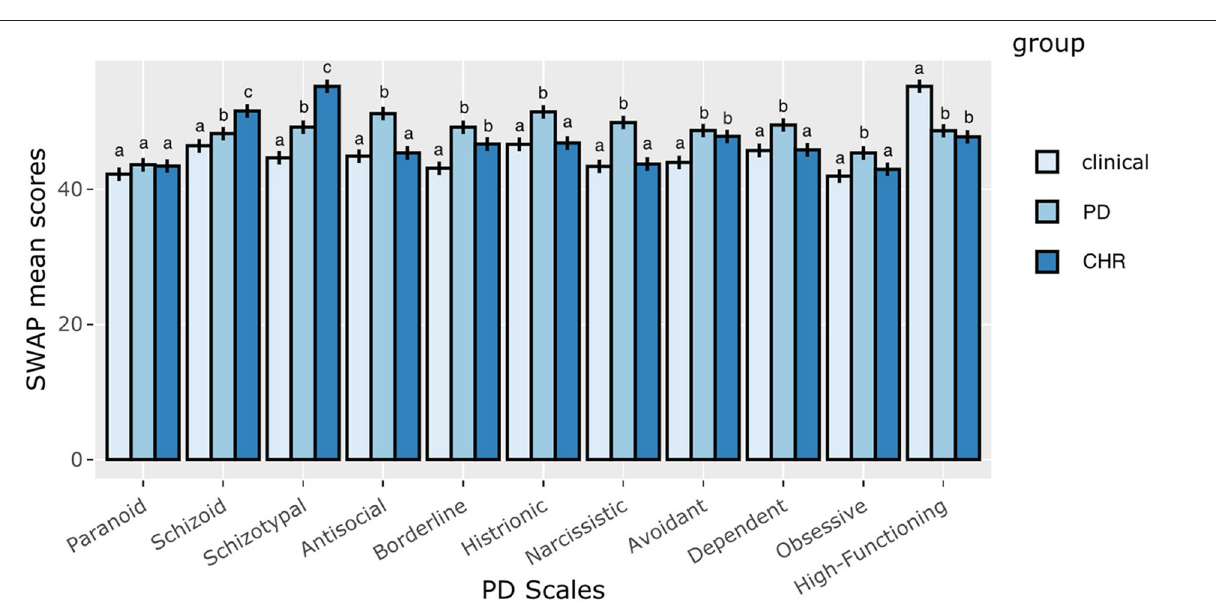
FIGURE 1 | CHR group, clinical high-risk group; PD group, personality disorder group; SWAP-200-A, Shedler–Westen Assessment Procedure-200 for Adolescents. Alphabetical superscripts indicate significant differences in the post hoc analyses. Means with different alphabetic superscripts (a, b, and c) were statistically significant, while means with identical alphabetic superscripts were not significantly